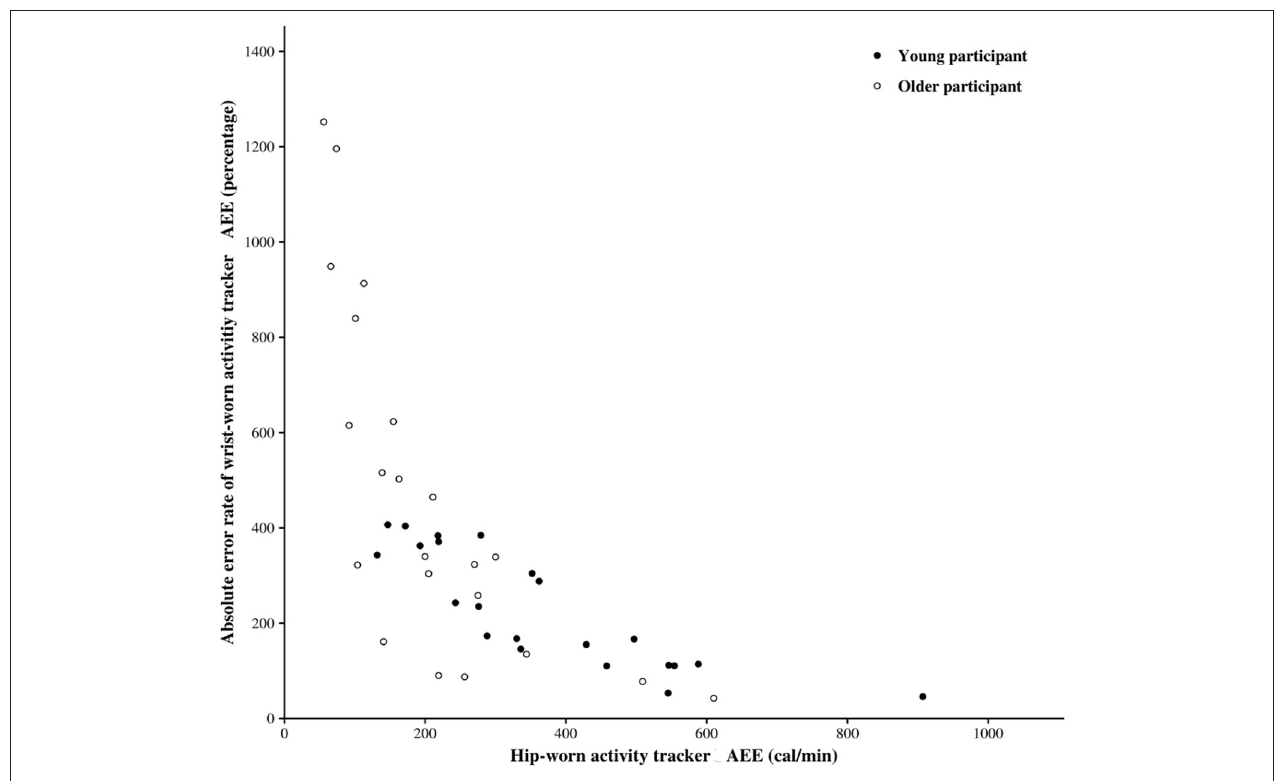
FIGURE 4 | Absolute error rate (AER) between active energy expenditure (AEE) provided by hip-worn and wrist-worn activity